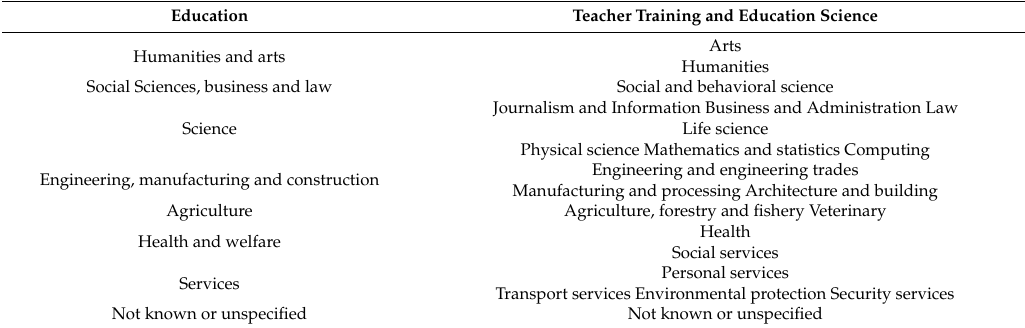
Table A1. Fields and Subfields Classification (ISCED 1997) 1 digit-level. 2